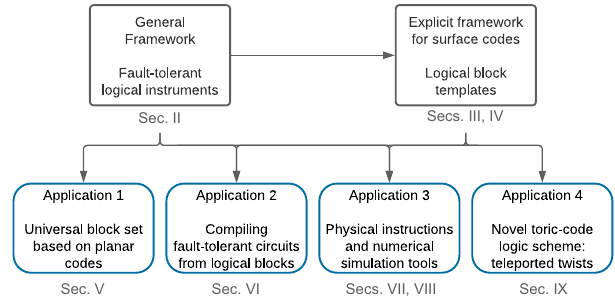
FIG. 1. Outline of the